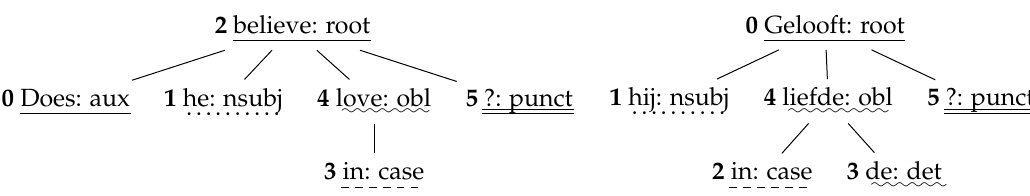
Figure 4. Example of the source dependency tree of ’Does he believe in love?’ (left) and the target dependency tree of its Dutch translation ’Gelooft hij in de liefde’ (right) (example sentences taken from Vanroy et al. [21]). The word alignments between the two sentences have been indicated by underlinings. In order to calculate ASTrED, the tree edit distance between these two trees is measured. (Literal translation of the Dutch sentence: * Believes he in the